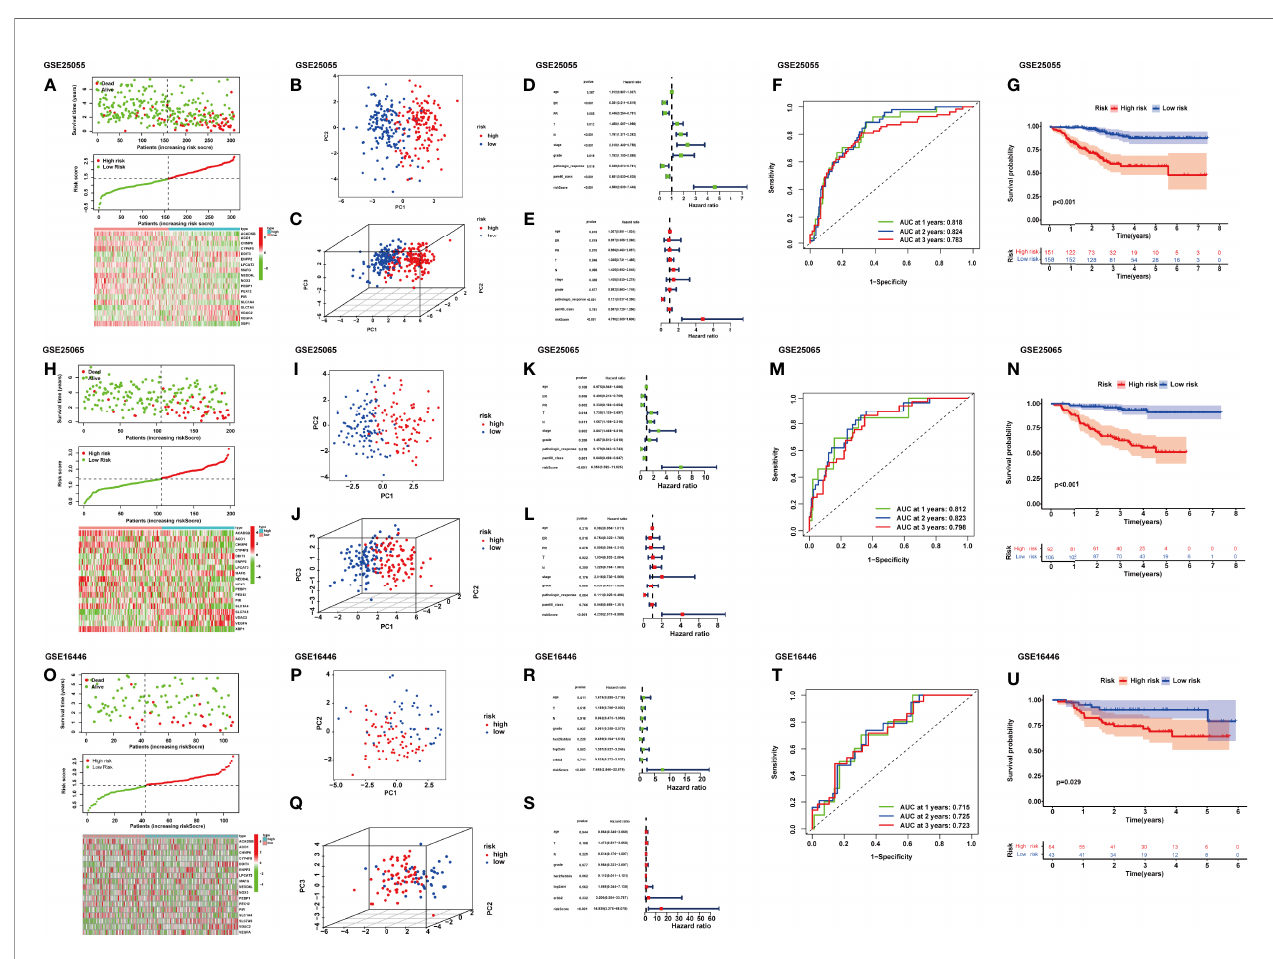
FIGURE 2 | Distribution of riskScore, scatterplot, and heatmap in the high-risk group and the low-risk group in GSE25055 (A) , GSE25065 (H) , and GSE16446 (O) . PCA (principal component analysis) for BRCA based on the riskScore in GSE25055 (B, C) , GSE25065 (I, J) , and GSE16446 (P, Q) . (D) Univariate and (E) multivariate Cox regression analyses of age, estrogen receptor (ER), progesterone receptor (PR), T, N, stage, grade, pathologic response, pam50 classi fi cation, and riskScore in GSE25055. (K) Univariate and (L) multivariate Cox regression analyses of age, ER, PR, T, N, stage, grade, pathologic response, pam50 classi fi cation, and riskScore in GSE25065. (R) Univariate and (S) multivariate Cox regression analyses of age, T, N, grade, her2- fi sh, top2atri, erbb2, and riskScore in GSE16446. Time-dependent receiver operating characteristic (ROC) curves for predicting 1-, 2-, and 3-year RFS in GSE25055 (F) , GSE25065 (M) , and GSE16446 (T) . Kaplan – Meier curves of the high- and low-risk subgroup patients in GSE25055 (G) , GSE25065 (N) , and GSE16446 (U)